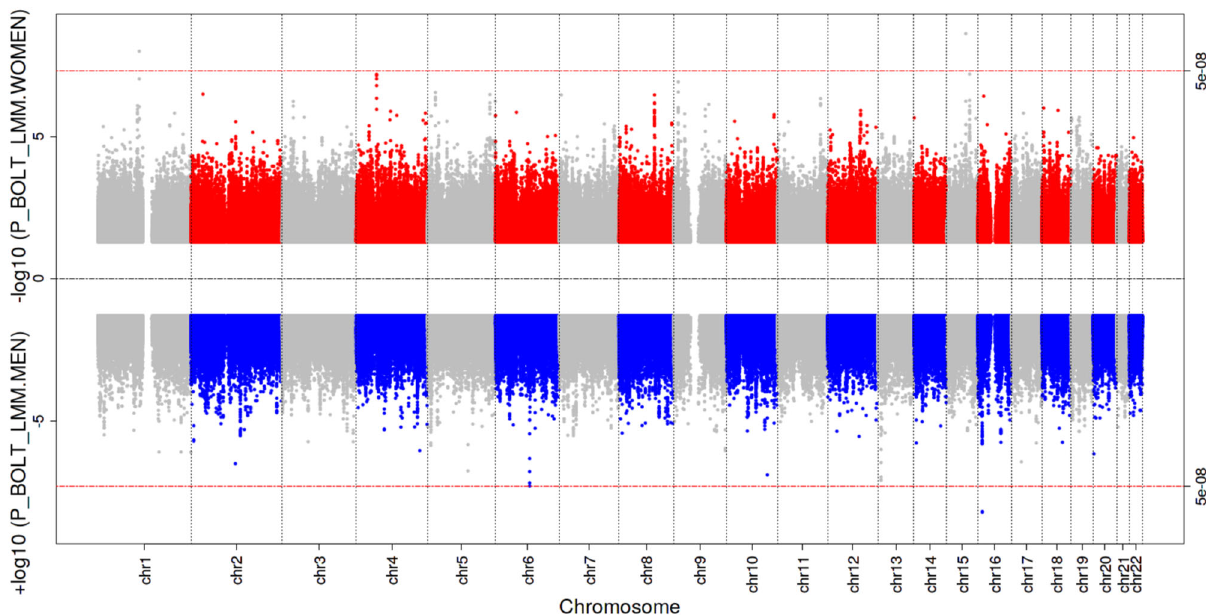
Fig. 3 Miami plot showing female and male-speci fi c associated p -values for mean-max cIMT. The − log10-transformed two-tailed P -value of each SNP from the GWAS for Mean-Max cIMT on the Y -axis (Adjusted for age and 5 PCs for each sex) and base-pair positions along the chromosomes on the X -axis. On top are the results for female-speci fi c analysis ( n = 3963) and on the bottom the results for the male-speci fi c analysis ( n = 3931). The red line indicates Bonferroni-corrected genome-wide signi fi cance ( p < 5 × 10 − 8